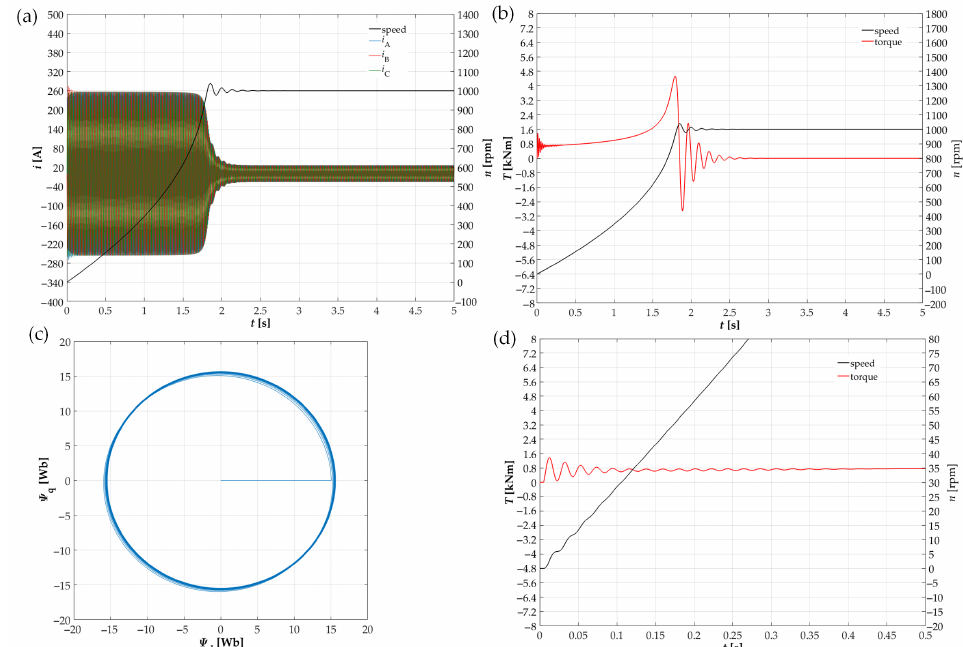
Figure 8. Waveforms of physical quantities for direct starting, with the voltage phase switching on delay of t delay = 5 ms and load torque T o = 0 Nm: ( a ) time waveforms of the stator currents in three phases and rotational speed; ( b ) time waveforms of the electromagnetic torque and rotational speed; ( c ) hodograph of stator fluxes; ( d ) fragment of the time waveforms of the electromagnetic torque and rotational speed, in the first moment of